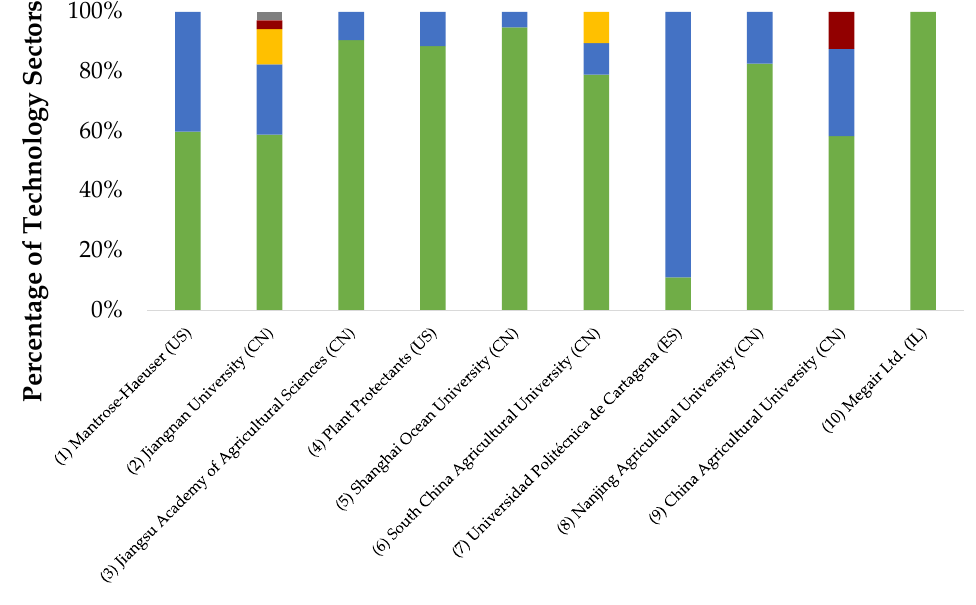
Figure 7. Top ten registered applicants for shelf-life extension technology according to technology sectors (Number one to ten is based on ranking in terms of number of patents). Note: CN = China, US = The United States, ES = Spain, and IL = Israel.